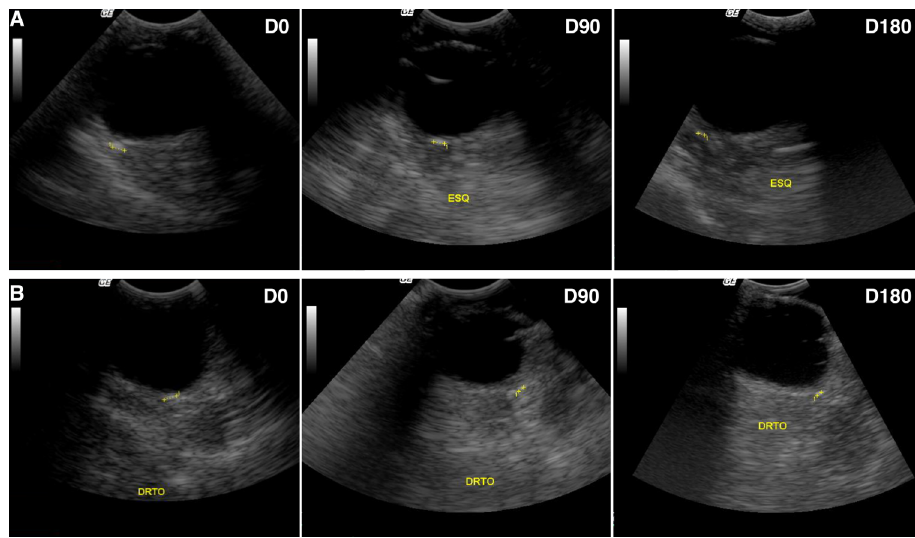
Fig 2. Decreased ocular size lesions in dogs treated with oxfendazole. Decreased ocular size lesions in dogs n. 5 (A) and n. 9 (B) at 0 (D0), 90 (D90) and 180 (D180) days post